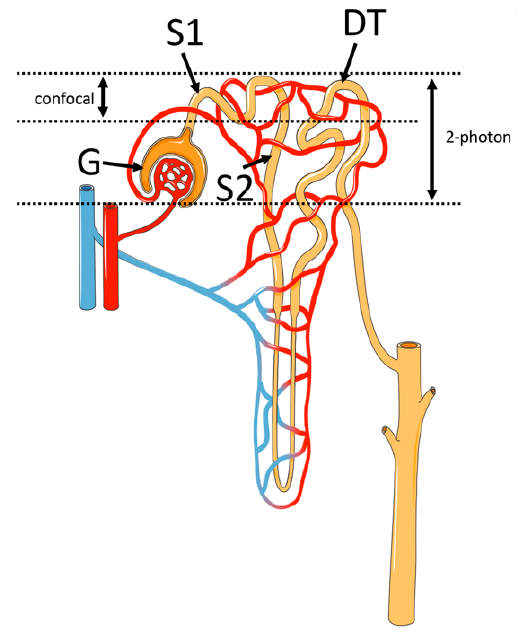
Figure 2. Schematic representation of the renal structures identified with 2PM. The nephron segments that are visible with confocal and 2PM are shown. As indicated by the vertical arrows, 2PM allows the renal structures to be imaged about 3 times deeper compared to confocal microscopy. G = glomerulus; S1 = S1 proximal convoluted tubule; S2 = S2 proximal convoluted tubule; DT = distal tubule. This figure was drawn adapting the vector image from the Servier Medical Art bank (http://smart.servier.com/; last accessed on 22 February 2022).